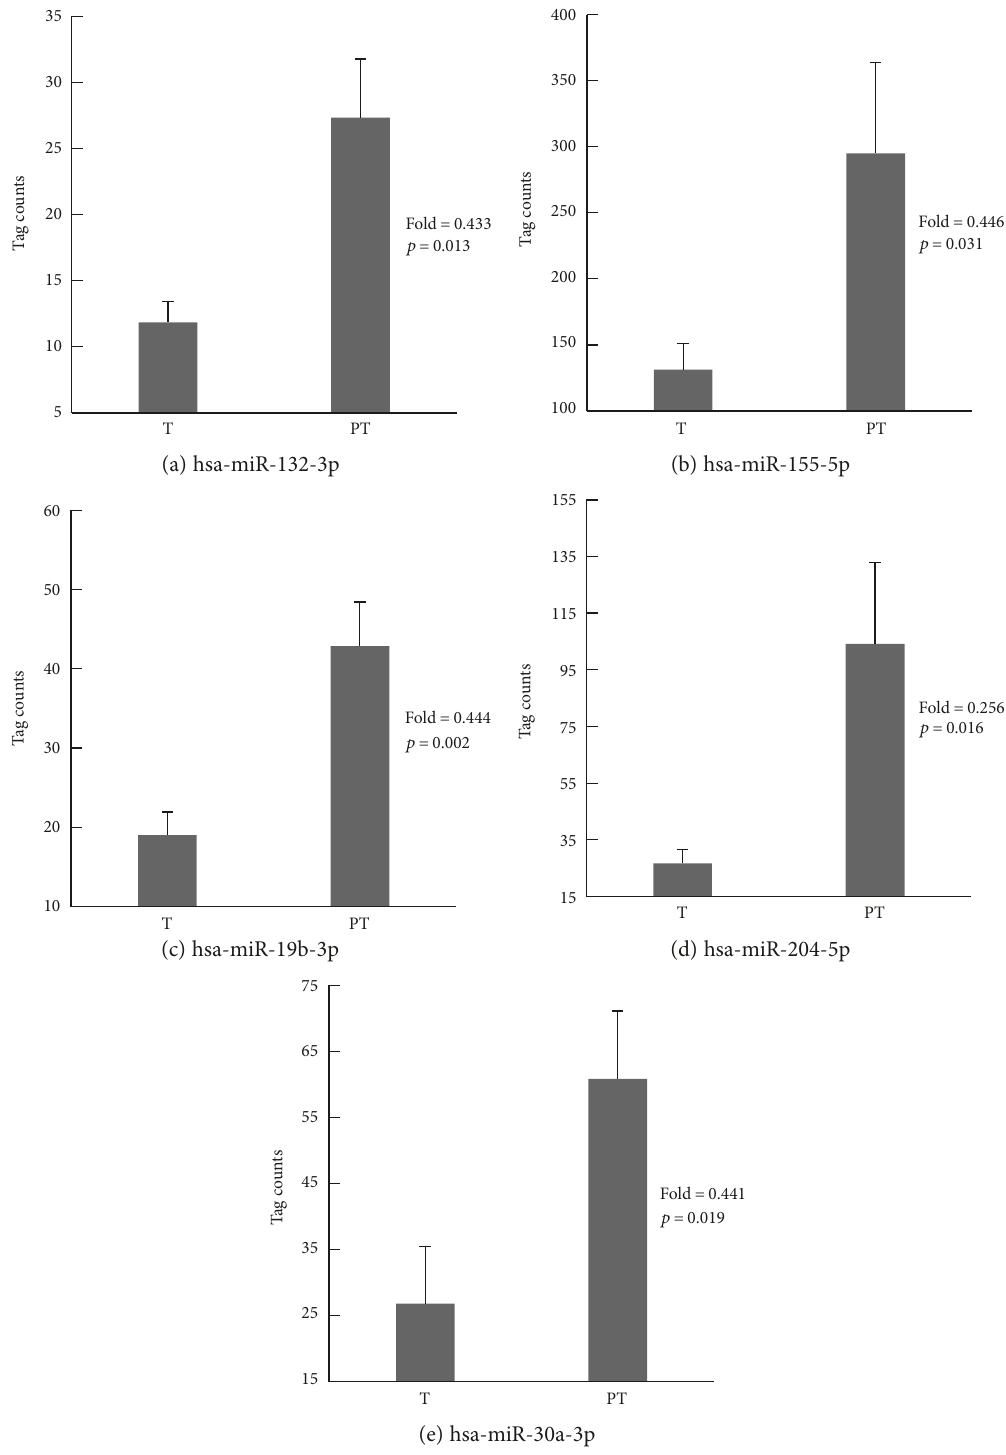
Figure 1: Five downregulated miRs between gastric tumor (T) and peritumoral tissue (PT) were identi fi ed by the high-throughput miR sequencing method. Tag counts refers to the normalized tag number of the mature miRs annotated in miRBase 21 (TPM), including the tag number of all samples. A fold change less than 0.5 (as well as p value less than 0.05) indicated that the expression of the miR was downregulated in gastric tumor compared with the corresponding adjacent tissue. Data are represented as mean ± SD, n = 6